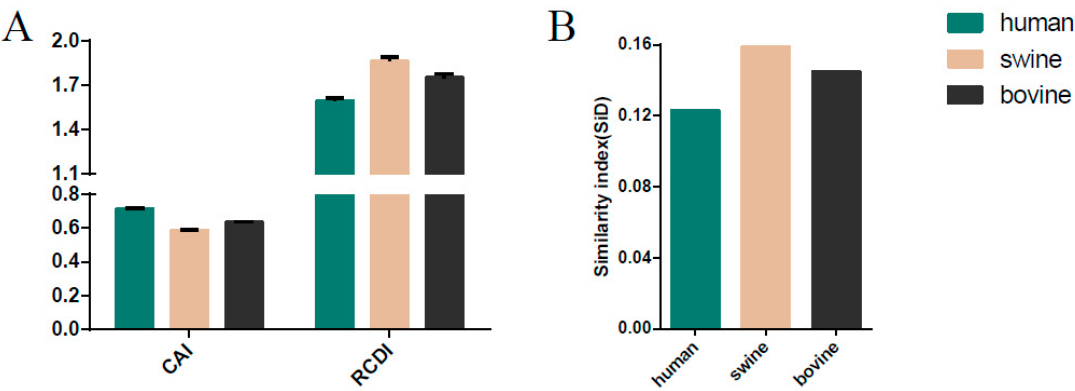
Figure 6. The codon adaption index (CAI), the relative codon deoptimization index (RCDI) ( A ), and similarity index (SiD) analysis of the ICV M gene in relation to the host species. Dark green, pink, and black indicate human, swine, and bovine, respectively.